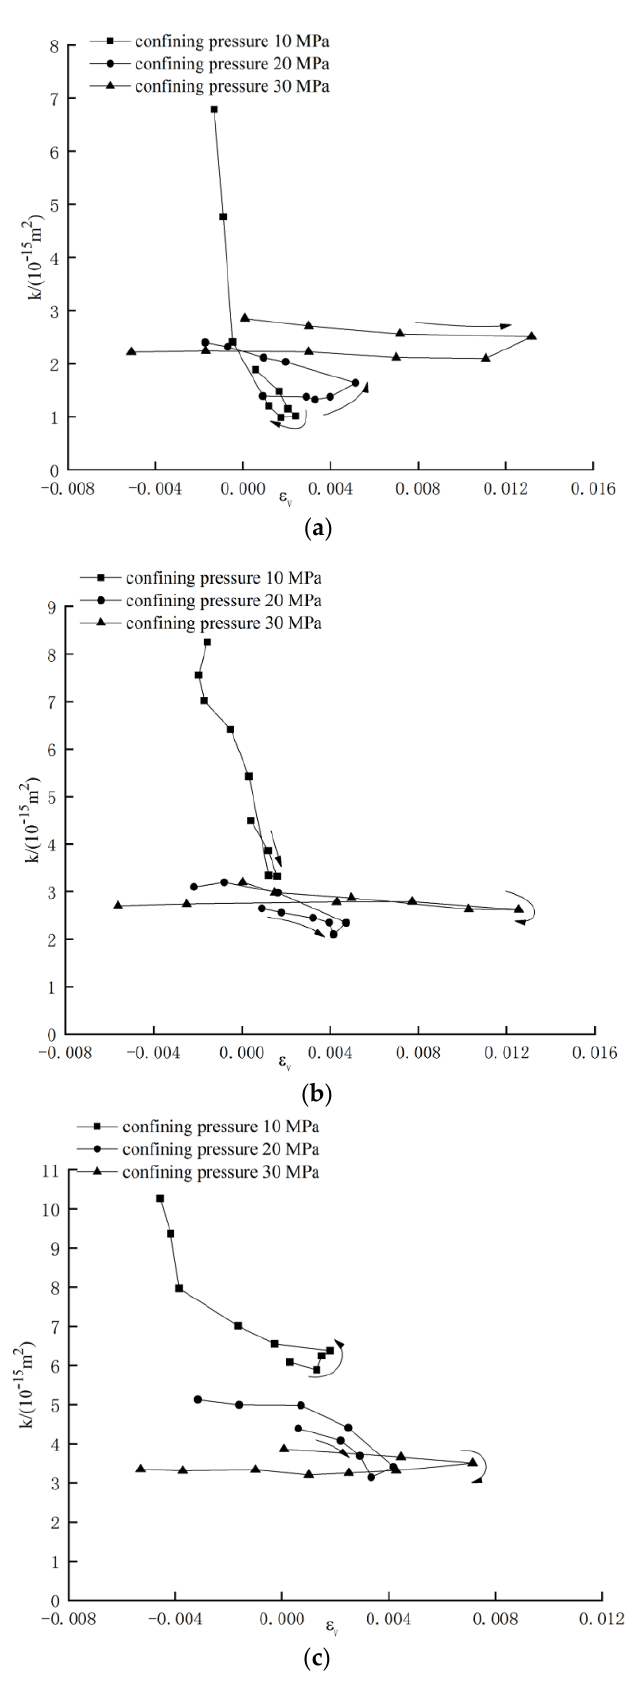
Figure 11. Relationship between permeability and volumetric strain of sandstone under different seepage pressures. ( a ) Pore pressure 1 MPa; ( b ) pore pressure 4 MPa; ( c ) pore pressure 7 MPa.